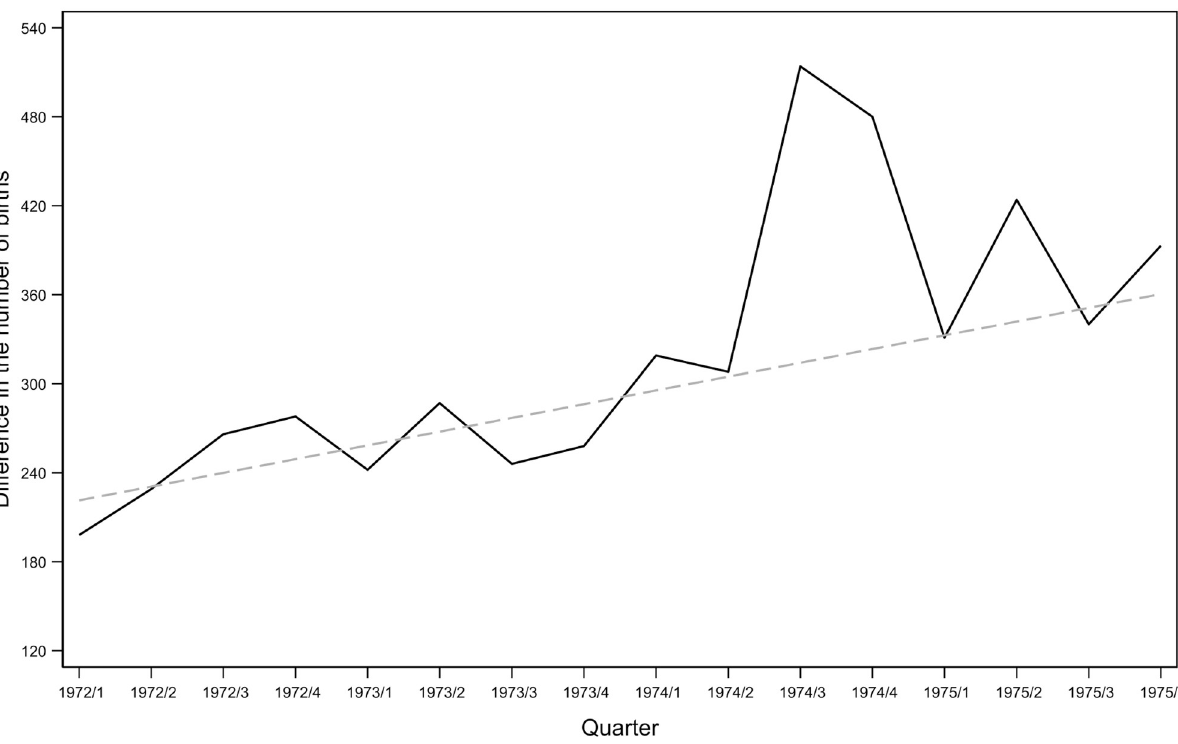
Fig 2. The difference between the number of births among mothers under age 35 and mothers over age 35. The graph shows quarterly values. The solid line shows the difference in the number of births. The dashed line shows the predicted values based on a linear OLS regression using data between 1972/1 and 1974/2. Difference: number of births among mothers under age 35 − number of births among mothers over age 35. Mothers under age 35 at the time of conception were 33.88–35.38 years old when giving birth; mothers over 35 at the time of conception were 35.77–37.27 years old when giving